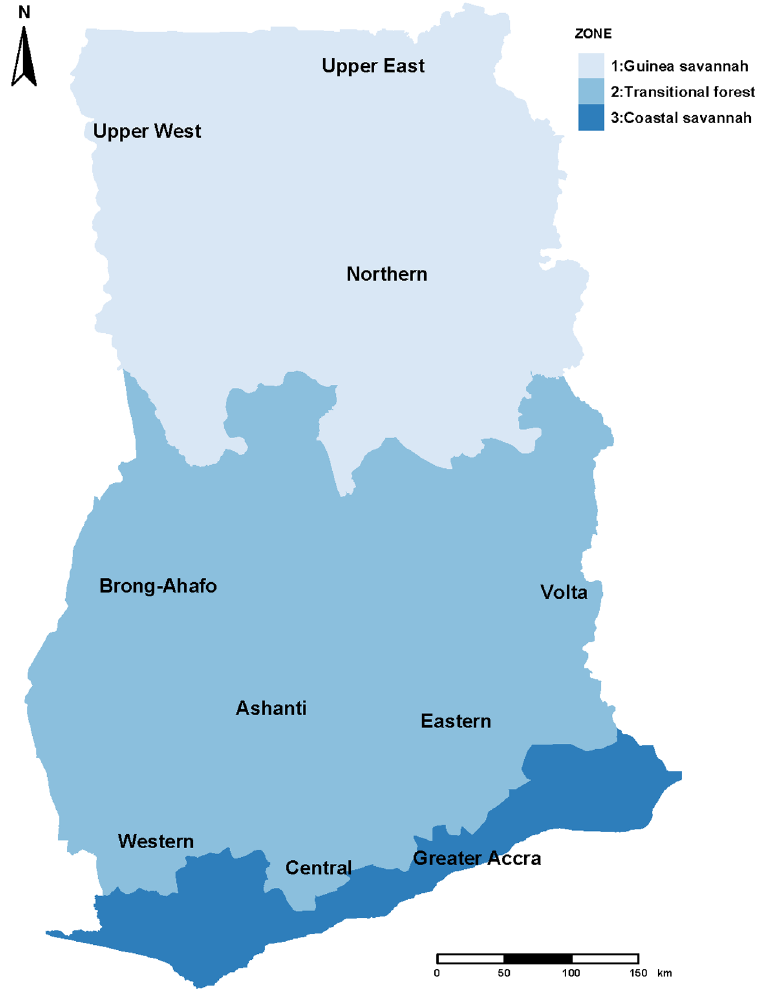
Fig 1. Map of Ghana showing the administrative regions and ecological zones. ( Data source: https://data.humdata. org/dataset/ghana-administrative-boundaries).